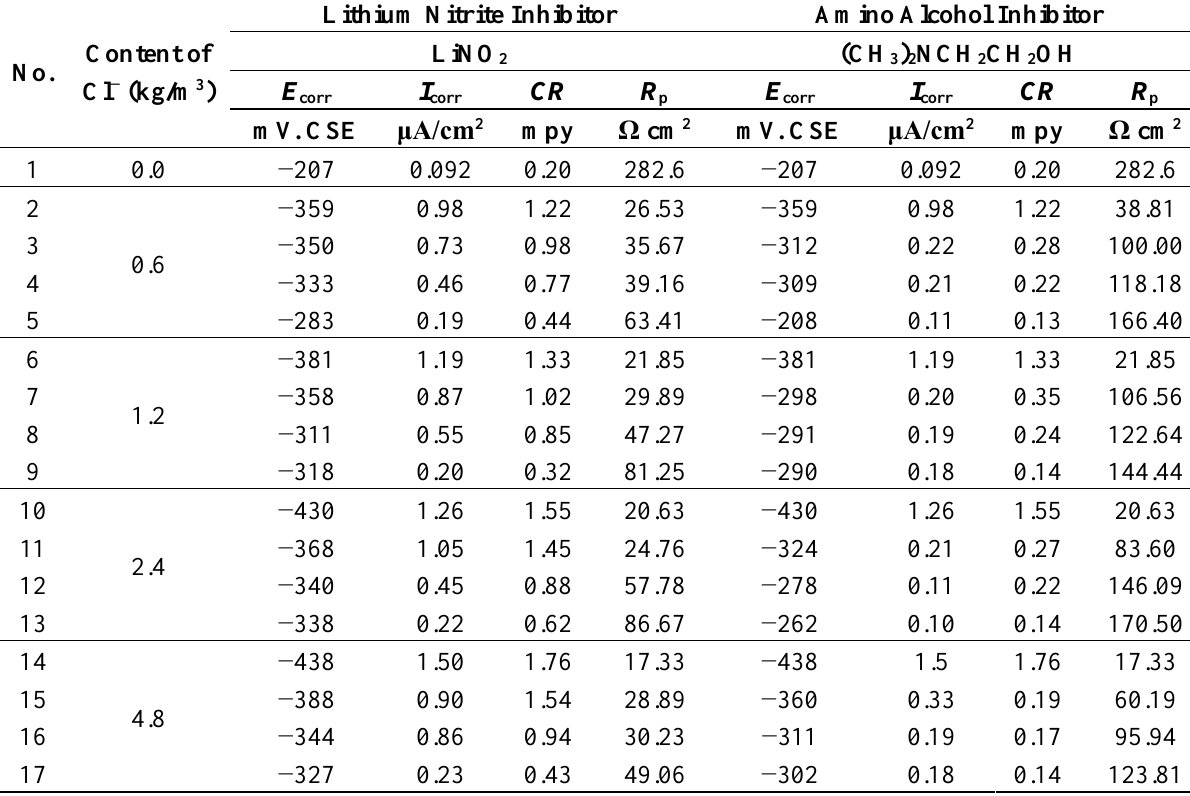
Table 7. Electrochemical measurement results of reinforcing steel specimen in solution. CSE: copper–copper sulfate